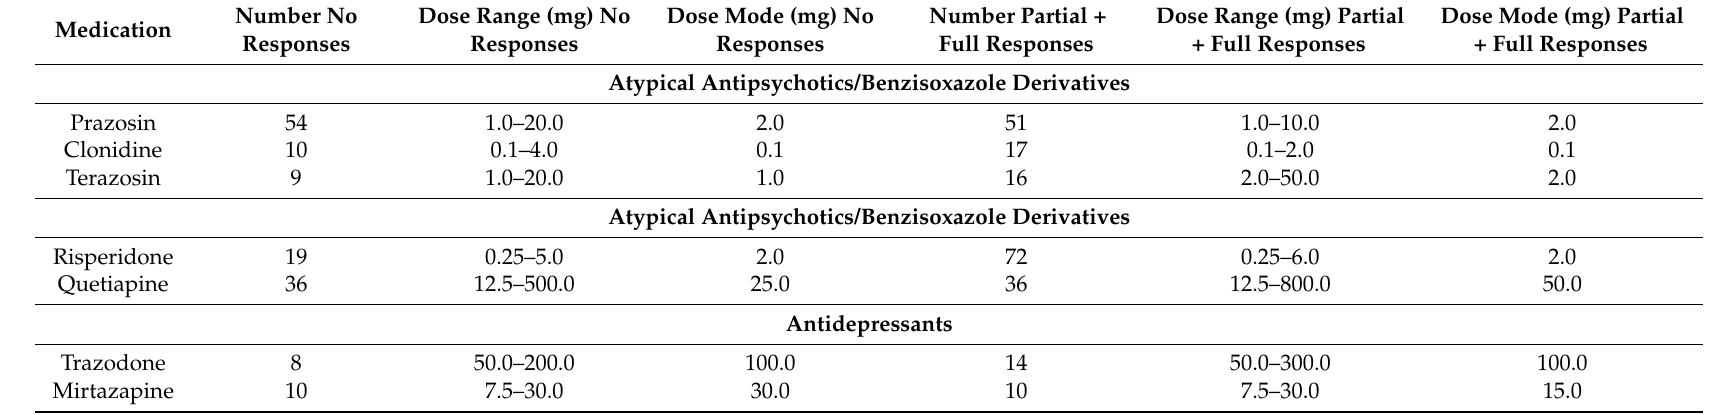
Table 2. Veterans Affairs Medical Center dose range and dose mode response for the seven most prescribed medications for combat